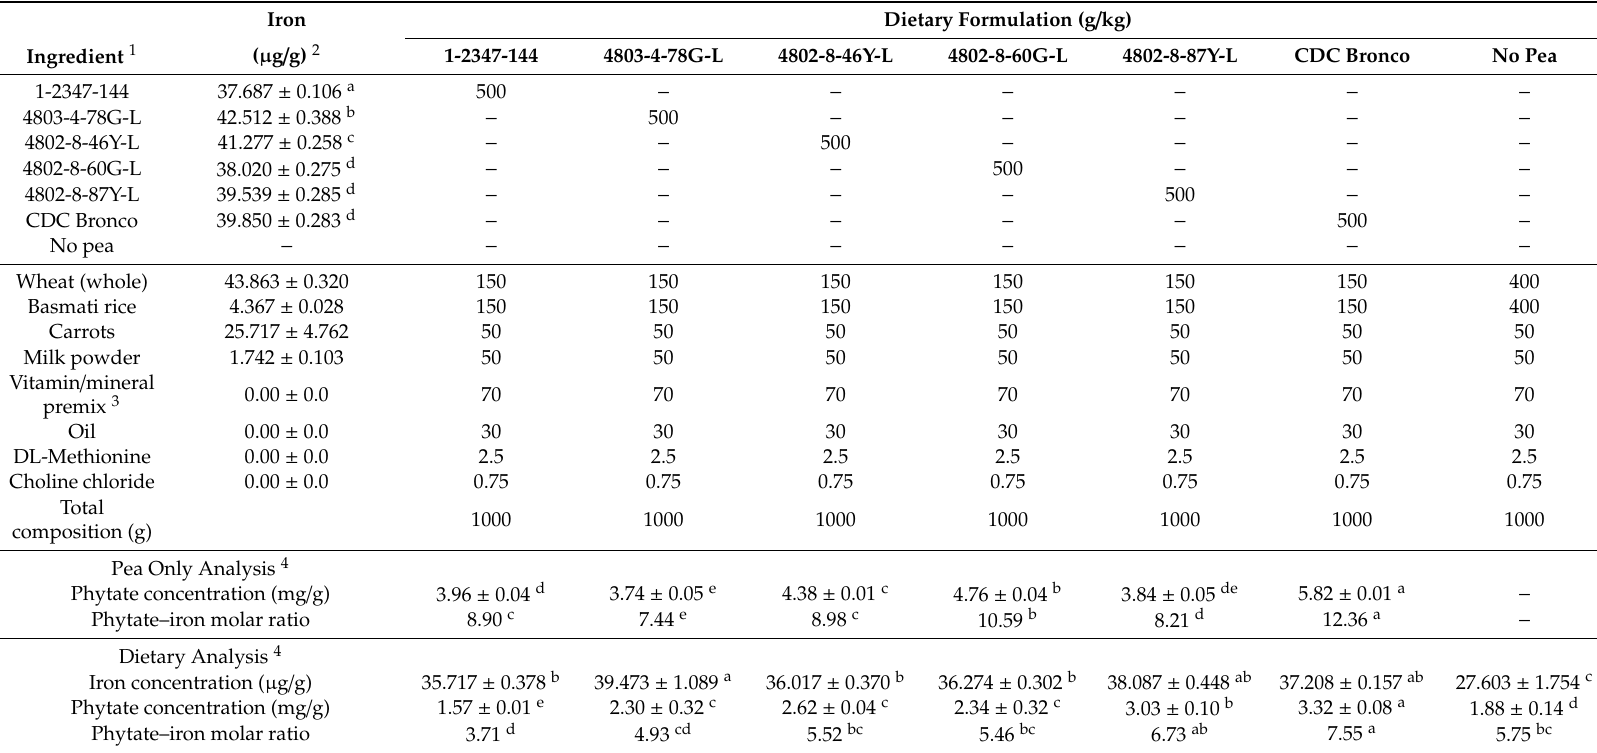
Table 1. Composition of the experimental pea-based diets 1